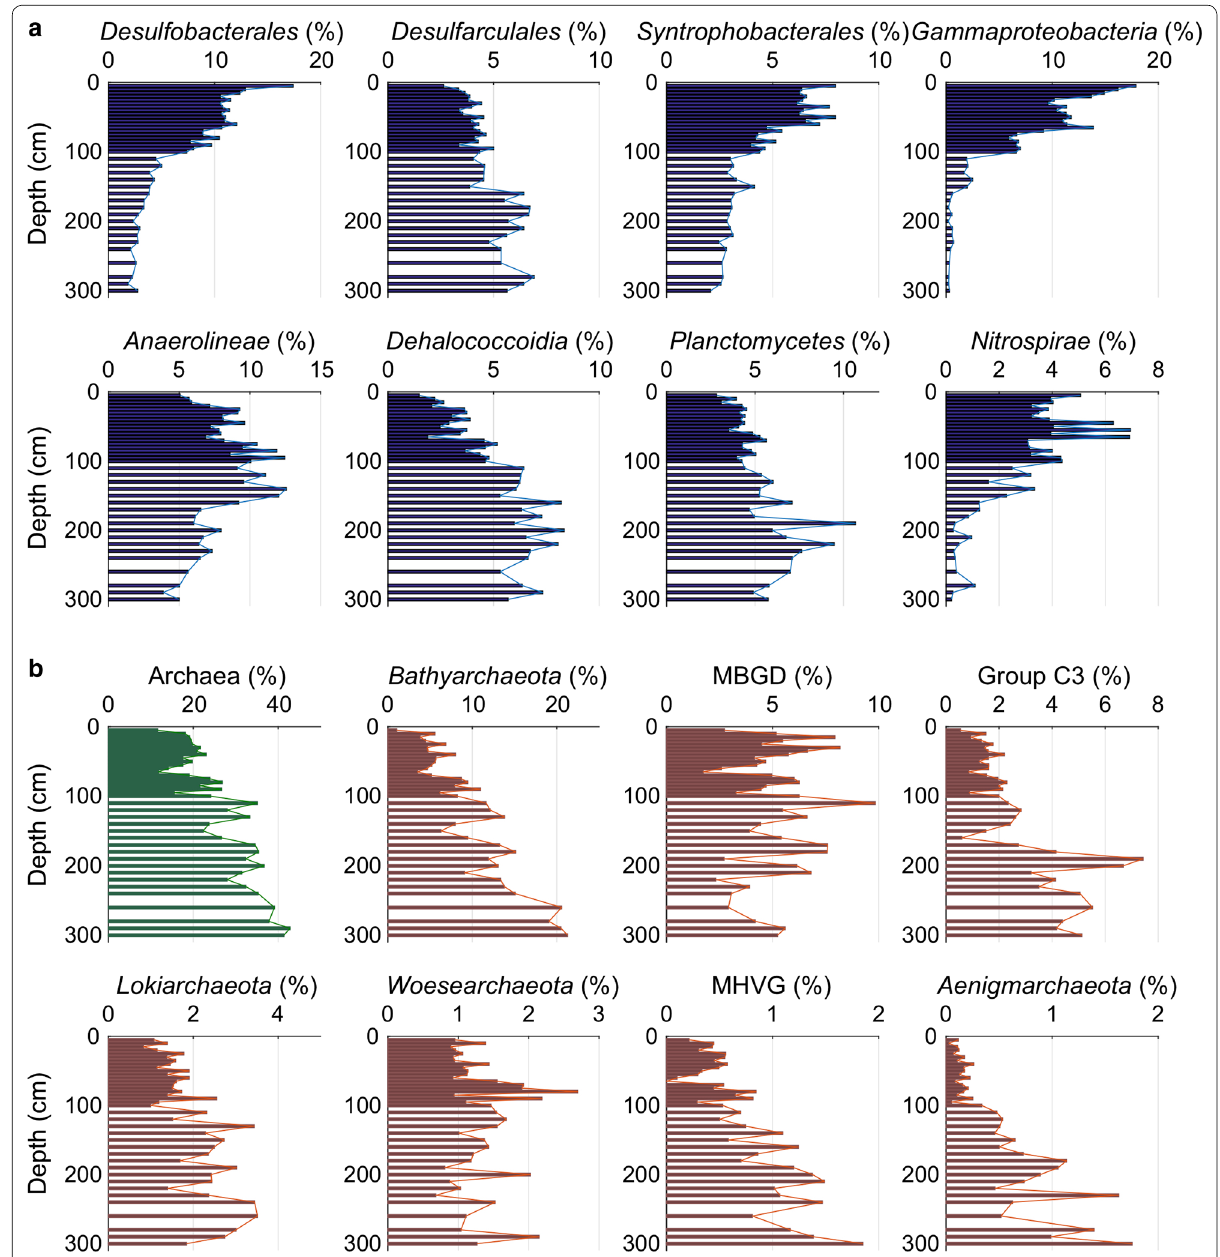
Fig. 3 Depth distributions of relative abundances of bacteria ( a ) and archaea ( b ). Dark blue red different archaeal =